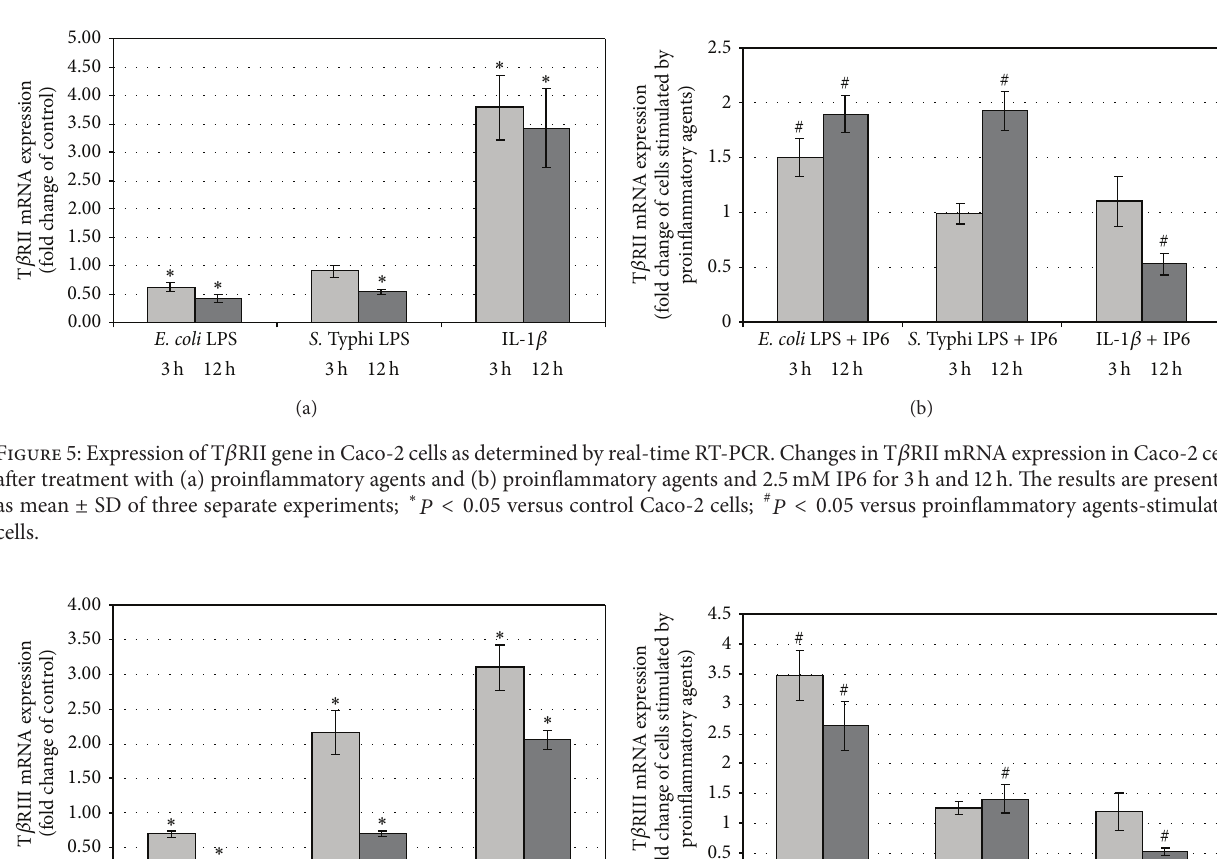
Figure 4: Expression of T 𝛽 RI gene in Caco-2 cells as determined by real-time RT-PCR. Changes in T 𝛽 RI mRNA expression in Caco-2 cells after treatment with (a) proinflammatory agents and (b) proinflammatory agents and 2.5 mM IP6 for 3h and 12h. The results are presented as mean ± SD of three separate experiments; ∗ 𝑃 < 0.05 versus control Caco-2 cells; # 𝑃 < 0.05 versus proinflammatory agents-stimulated cells.